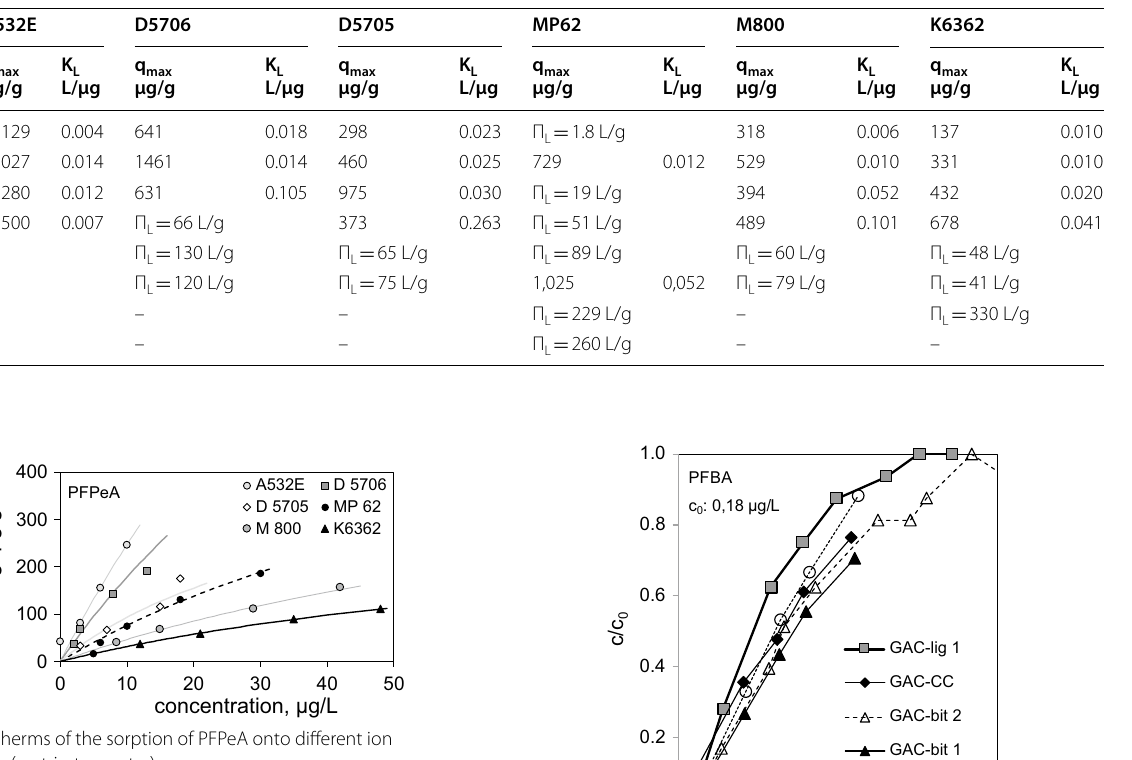
Table 6 Langmuir equilibrium parameters (Eq. (1) and (2)) for PFAS adsorption onto investigated IEX out of drinking water